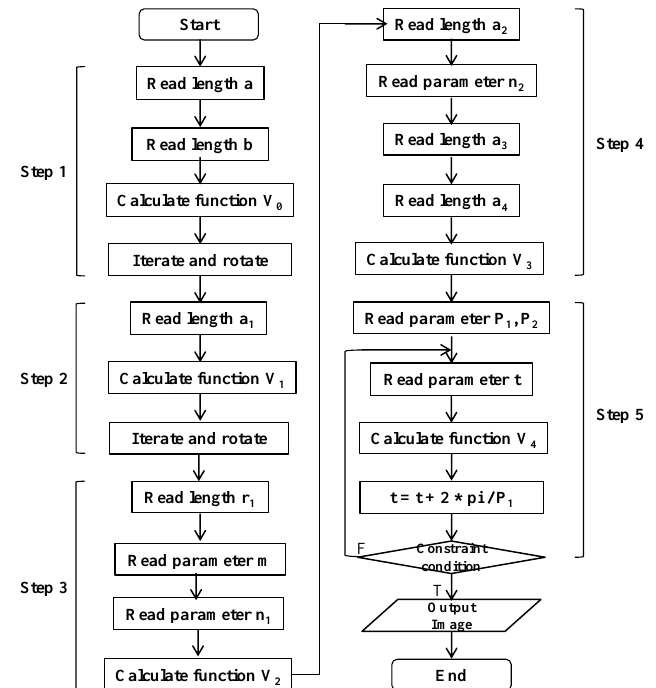
Figure 3. Flower-generation algorithm flow. Where parameters a and b control the basic shape of the flower-leaves; parameter a 1 controls the size of the petals; parameter r 1 controls the size of the pistil and parameter m controls the number of pistils; parameter a 2 controls the size of the flower-core and parameter a 3 controls the size of the round shape of the flower-core.